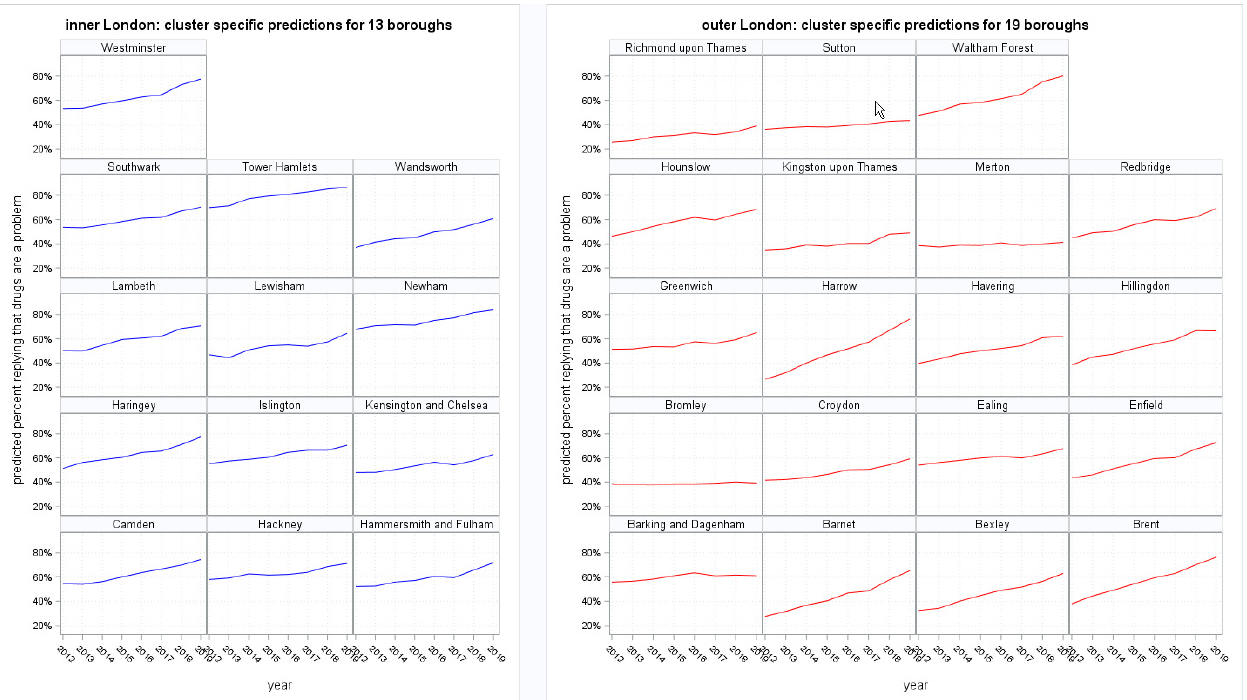
Figure 1. Borough-specific predictions by year and London area: line plots. Figure 1 . Borough-specific predictions by year and London area: line plots . Table 1. Cluster-specific time trend (Odds Ratio sorted in descending order) .